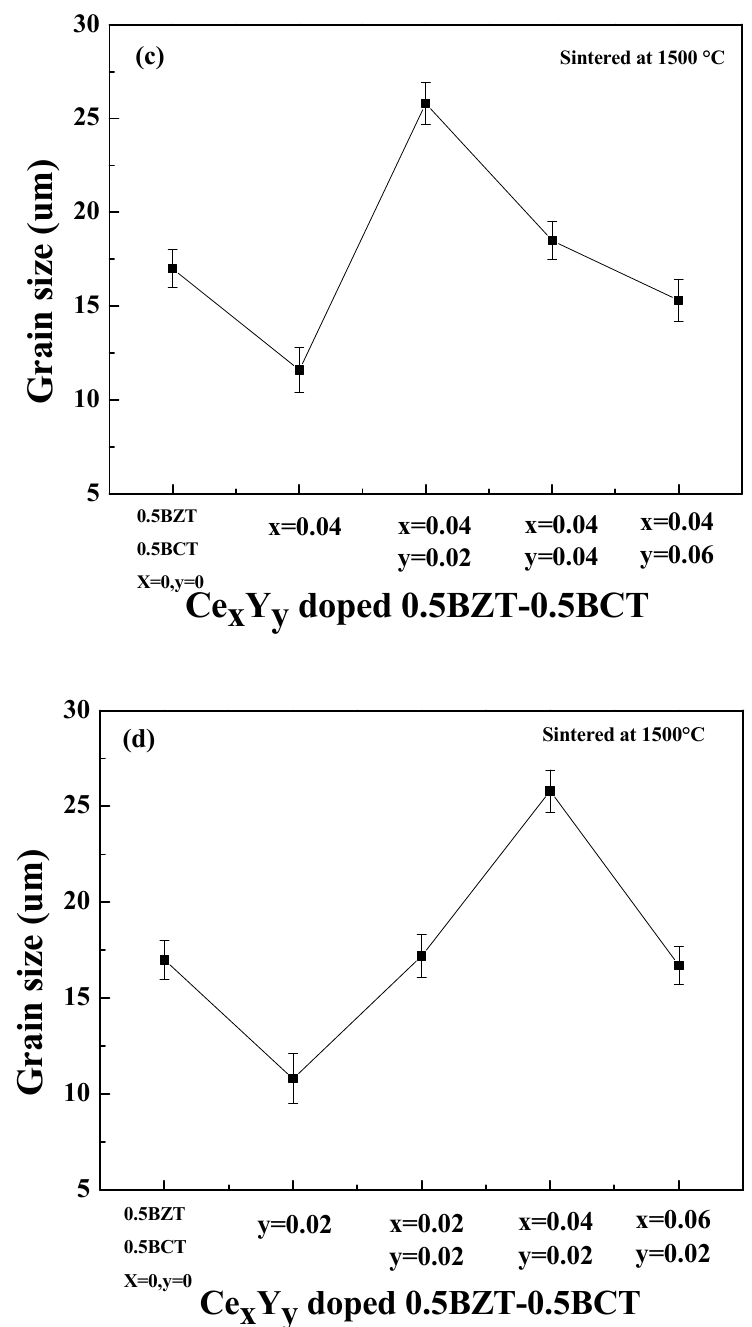
Figure 5. The measured grain size of Ce and Y doped BCZT ceramics from the SEM images. ( a ) for the Ce 0.04 Y y doped BCZT ceramics, ( b ) Ce x Y 0.02 doped BCZT ceramics, ( c ) Ce 0.04 Y y doped BCZT ceramics grain size, ( d ) Ce x Y 0.02 doped BCZT ceramics grain size.